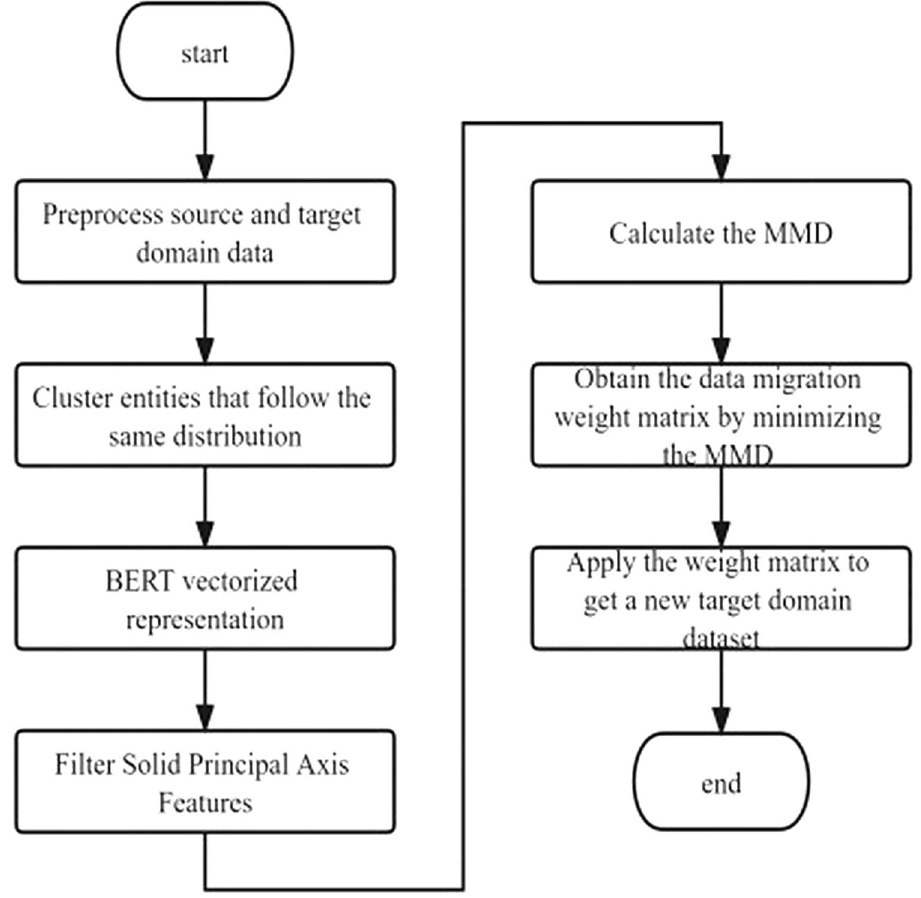
Fig. 3 Data migration flow chart based on entity